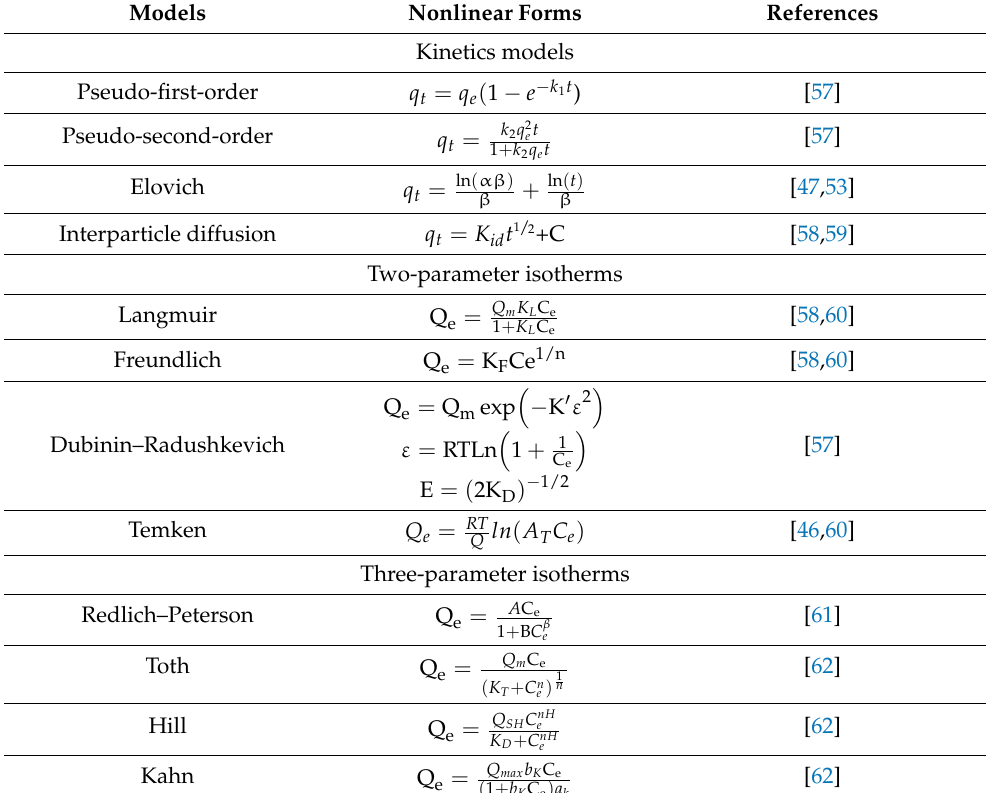
Table 2. Nonlinear forms of kinetics and isotherms